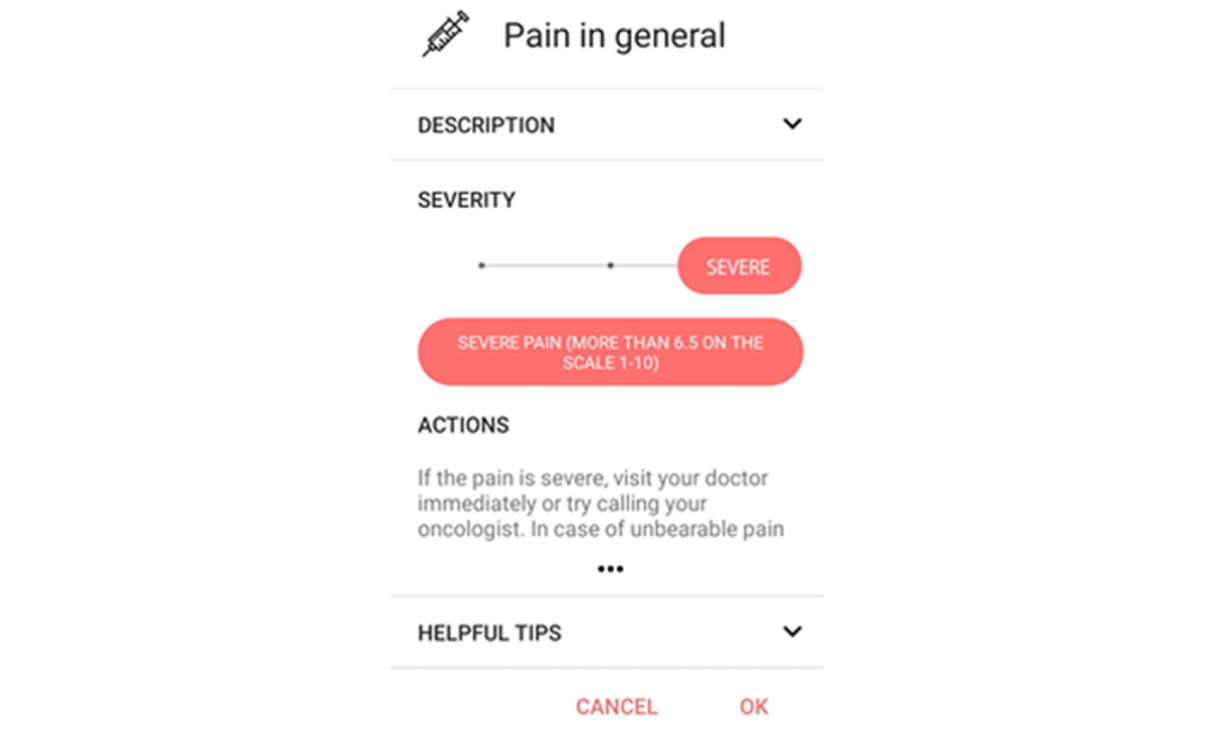
Figure 1. The mobile app user interface with customized slider controls allows for quick daily recording of symptoms and their severity levels.